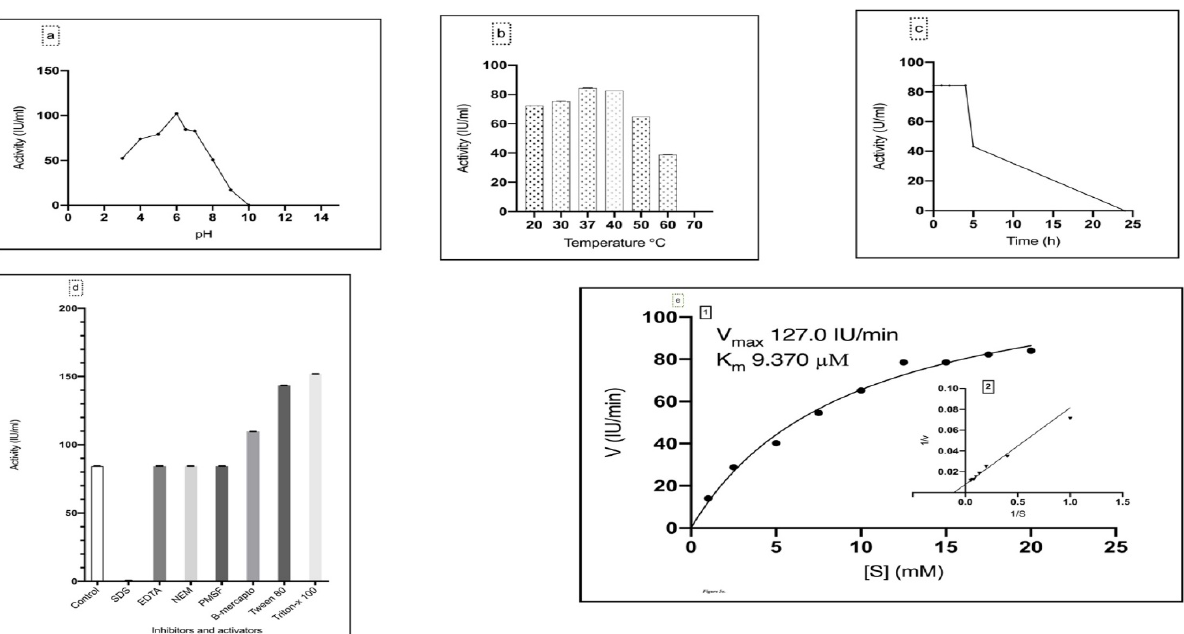
Figure 3. ( a ) The effect of pH on the purified asparaginase from L. theobromae . ( b ) The effect of temperature on the purified asparaginase from L. theobromae . ( c ) Thermal stability of purified asparaginase from L. theobromae at 37 ◦ C. ( d ) Effect of inhibitors and activators on purified asparaginase from L. theobromae . ( e ) Purified asparaginase kinetics. 1. Michaelis Menten plot for the purified asparaginase enzyme from L. theobromae . 2. The different activities value of purified asparaginase from L. theobromae with increasing the substrate concentrations.